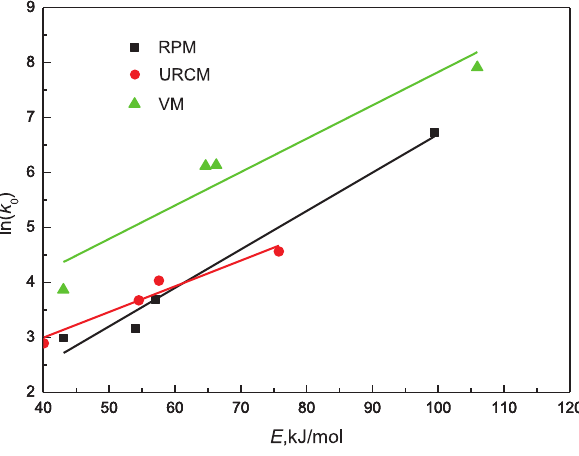
Figure 3: Relation between ln( k 0 ) and E